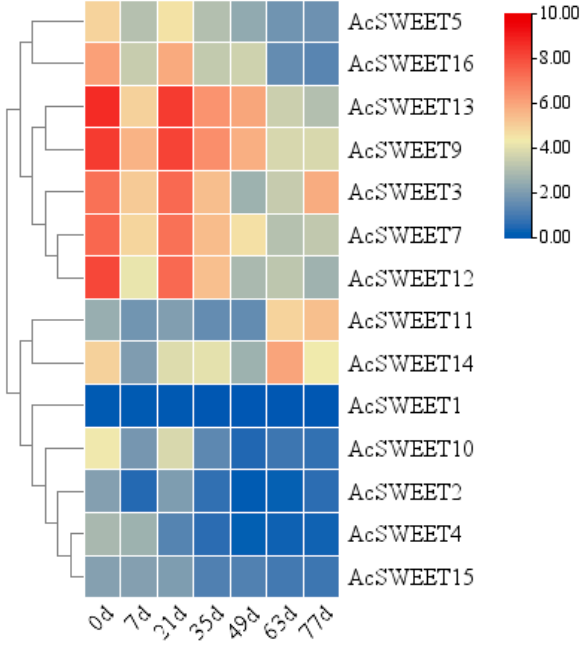
Figure 5. Expression analysis of AcSWEETs during ‘Comte de paris’ fruit development conducted by qRT-PCR. d, days after anthesis.